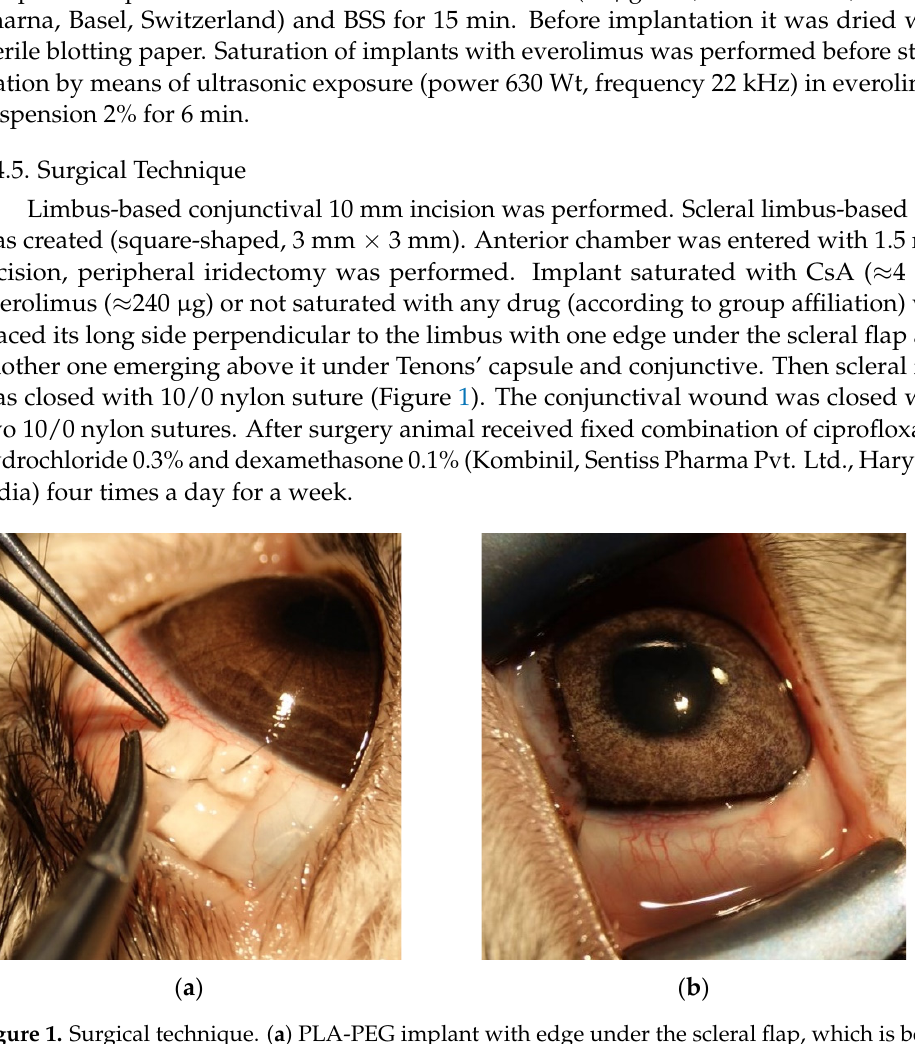
Figure 1. Surgical technique. ( a ) PLA-PEG implant with edge under the scleral flap, which is being fixed; ( b ) Post-op bleb. Proximal edge of the implant is visible through conjunctiva.